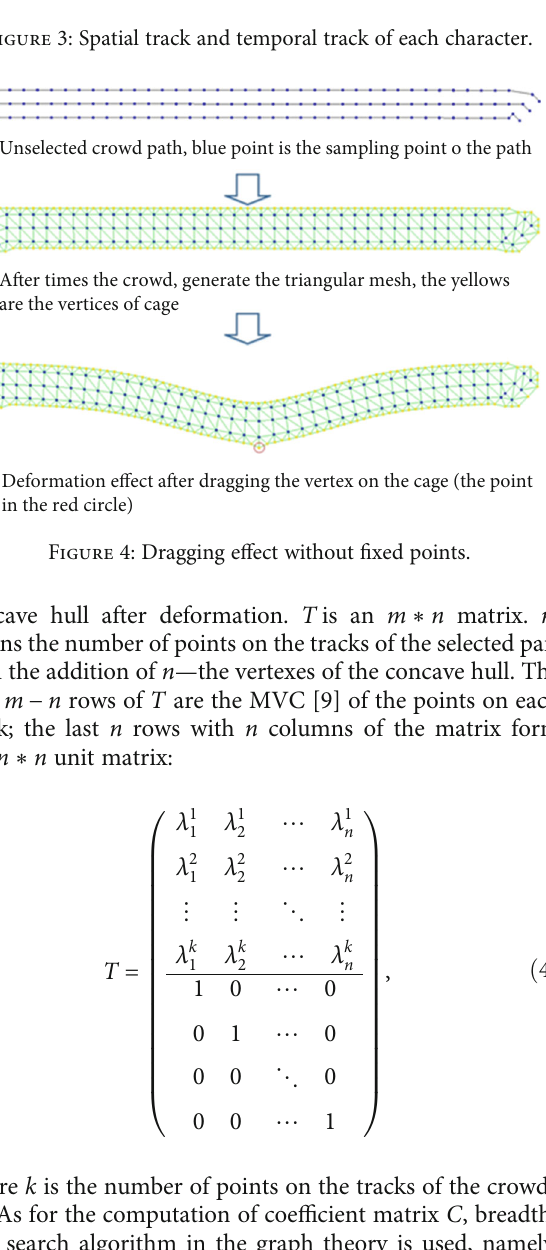
Unselected crowd path, blue point is the sampling point o the path